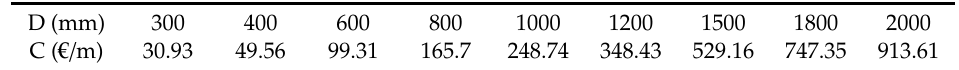
Figure 5. Selected lines (Green Color) to potentially be replaced for p m1 = 10%.